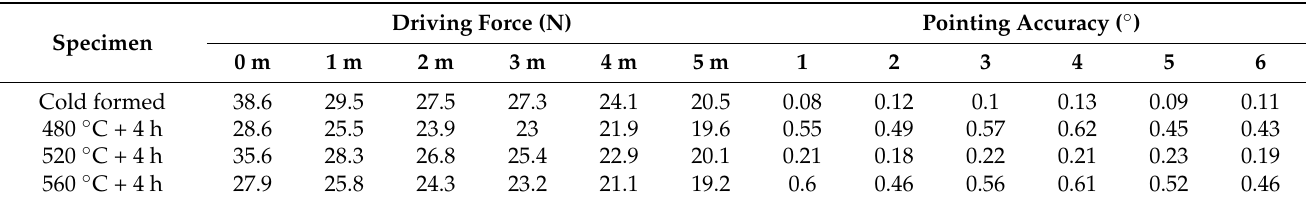
Table 3. Data of driving force and pointing accuracy for CSPB STACER and winding and stabilization STACER.